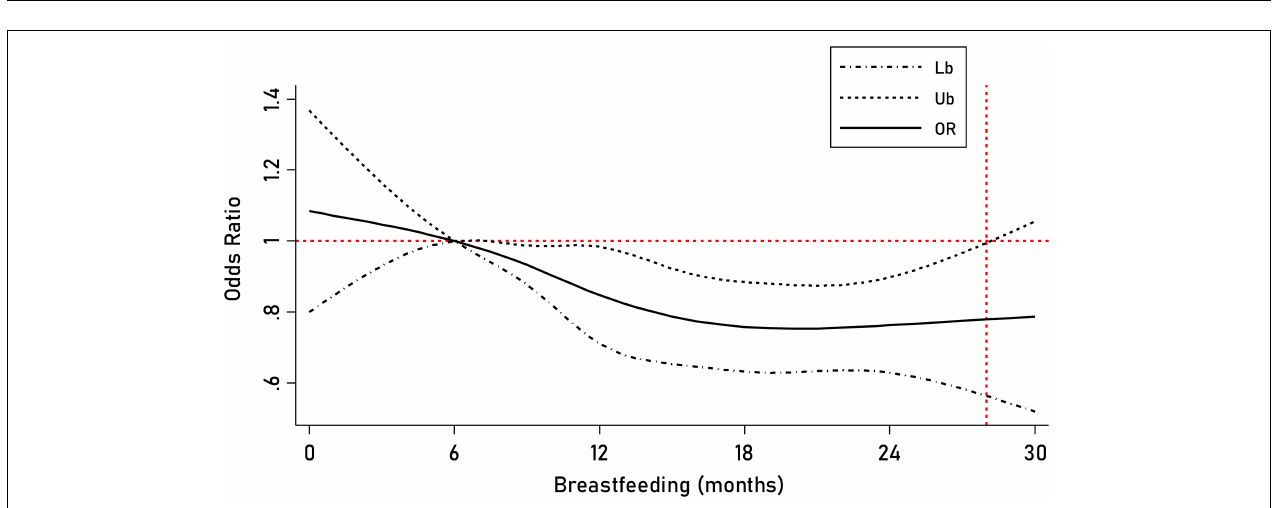
FIGURE 1 | Decision curve analysis for C-ASQ-defined ADHD susceptibility by adding significant factors to the basic model. The orange solid line corresponds to the basic model that includes sex, age, region, BMI (body mass index), family income, maternal education, and parental education, parent’s age while children birth, parent’s BMI, delivery mode gestational weight gain, probiotics supplemented, vitamin D supplement duration, screen time. The green solid line corresponds to the full model that includes both factors in the basic model and the five newly- identified significant factors including children’s second hand smoking exposure, and parental self-rating patience. Larger area between the two lines represents better accuracy of the full prediction model.